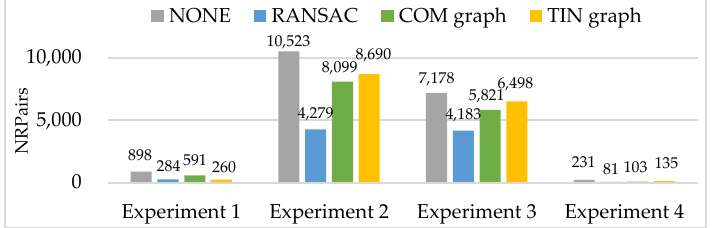
Figure 9. Experimental results of the number of remaining matching point pairs (NRPairs).